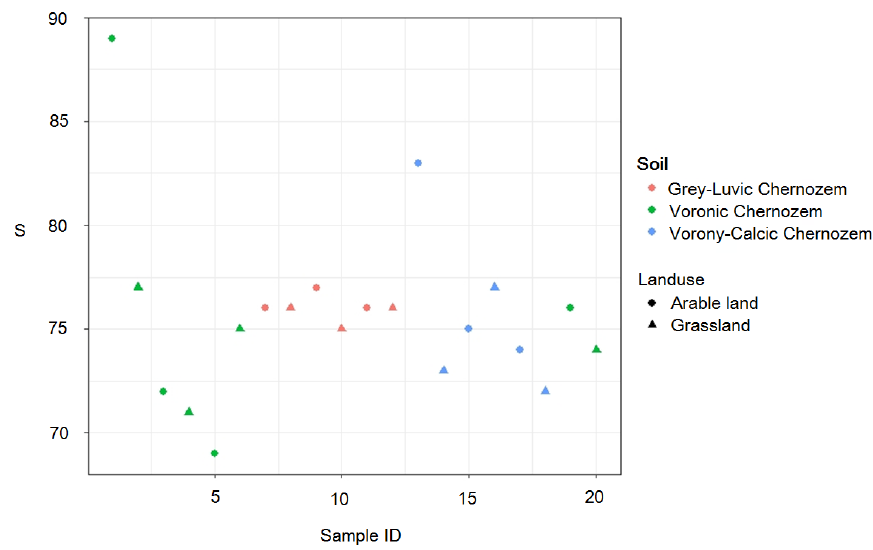
Figure 2. Family richness of the samples’ scatter plot. Richness values are deferred on the vertical axis. Nonarable sites marked as grassland. Odd sample IDs and even ones to the right of them correspond to paired samples.